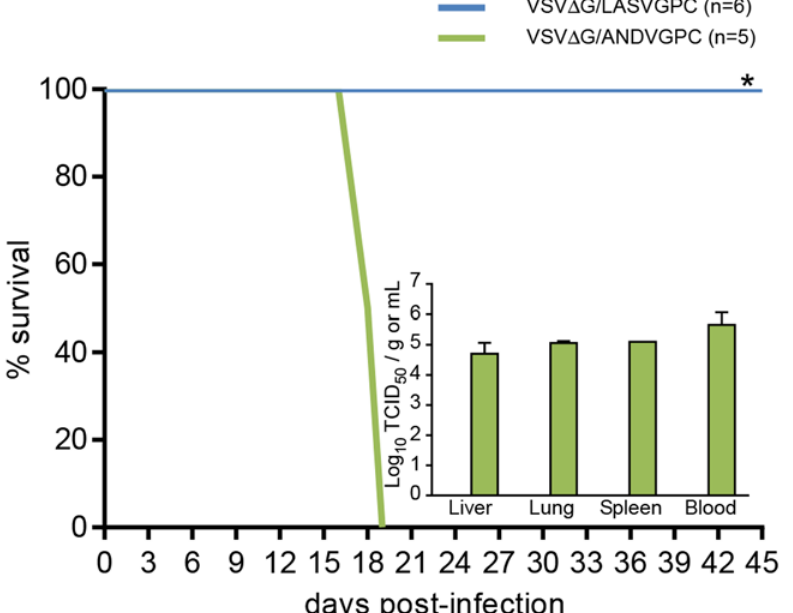
Fig 2. VSV Δ G/LASVGPC protects strain 13 guinea pigs from lethal challenge with a Liberian Lassa virus isolate. Adult, inbred strain 13 guinea pigs were immunized with 1 x10 6 pfu of VSV Δ G/LASVGPC (n = 9) or VSV Δ G/ANDVGPC (n = 5) and challenged 28 days later with a lethal dose of Lassa virus strain Z- 132. Animals were monitored for disease progression for 45 days. At the time when control (VSV Δ G/ ANDVGPC immunized) animals demonstrated signs of advanced disease requiring euthanasia, three animals per group were euthanized and samples collected for virological analysis (inset). * p = 0.0022.